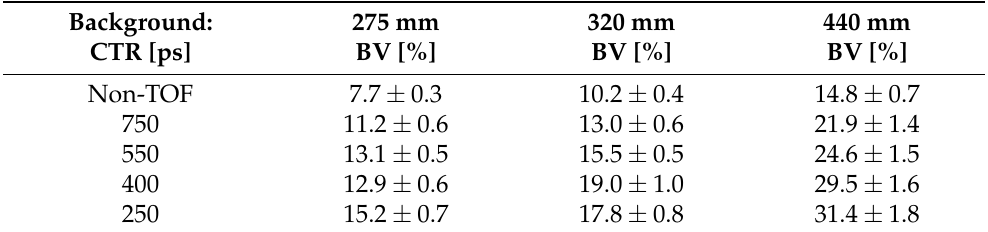
Table 3. Background variability (2 mm) at 50 updates, as a function of CTR and background diameter. Values reported as mean ± one standard error.